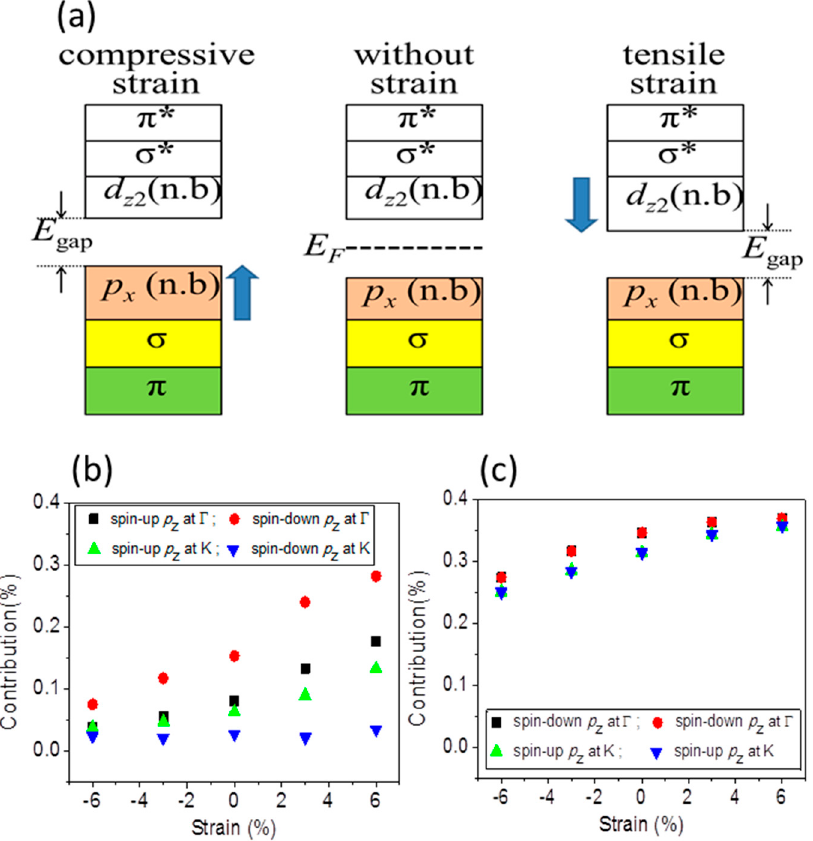
Figure 7. ( a ) The illustration for energy gap changing with strain. The spin polarized p z state change with increasing strain: ( b ) at K and Γ points for Fe terminated α -Fe 2 O 3 1 × 1 × 3 film; and ( c ) at K and Γ points for O terminated α -Fe 2 O 3 1 × 1 × 3 film.